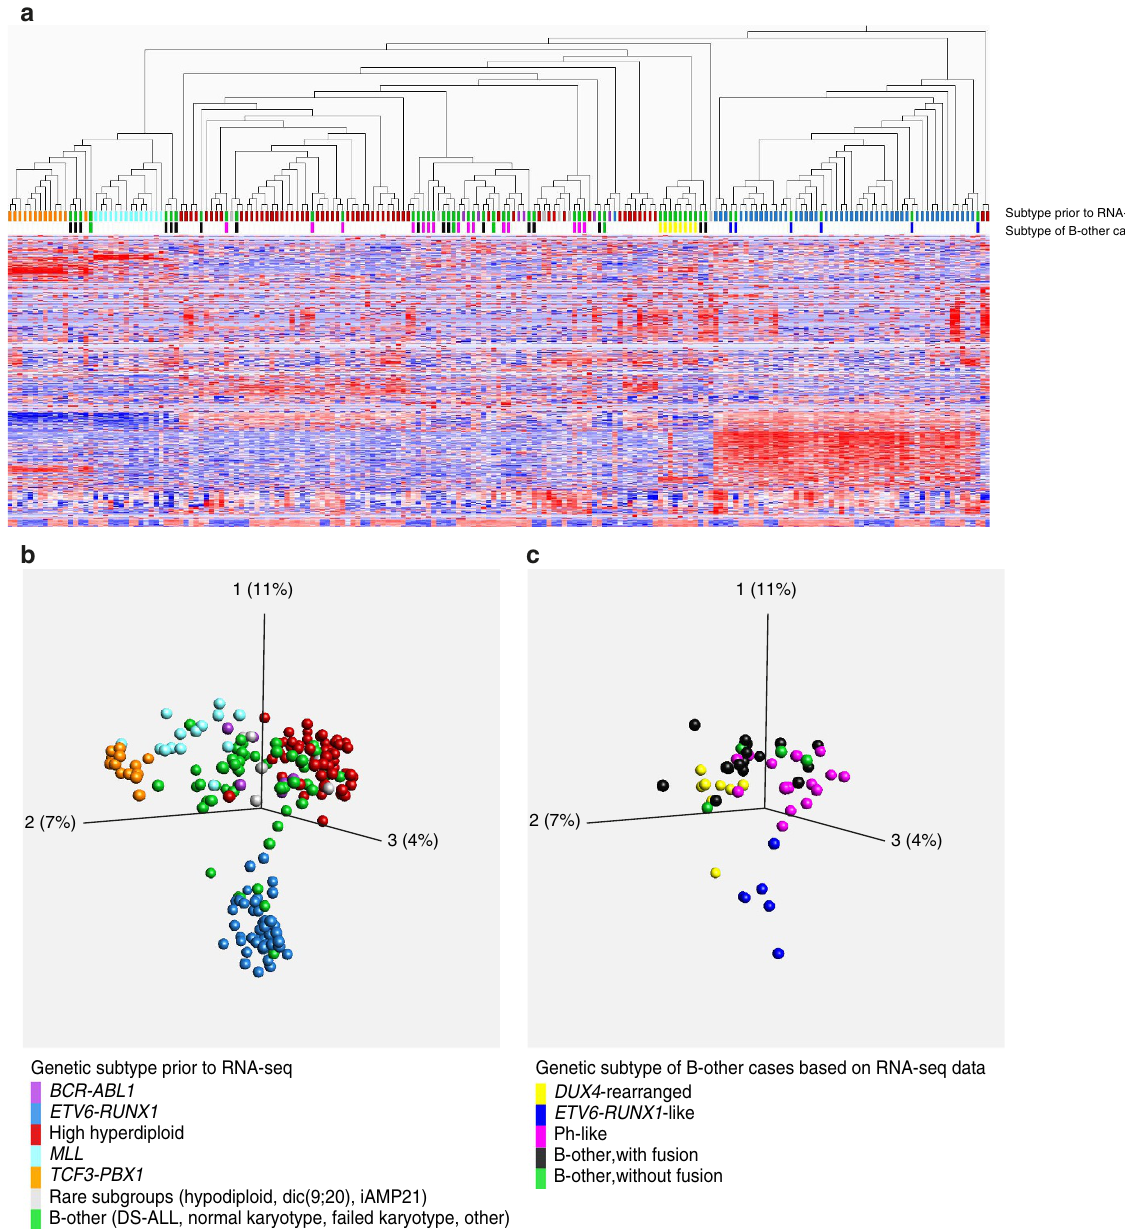
Figure 4 | Hierarchical clustering and principal component analyses of RNA-seq gene-expression data. A variance threshold was set at standard deviation 0.285, retaining 638 variables. The colour-coding of BCP ALL subtypes, used throughout the figure, is indicated in the bottom. ( a ) Unsupervised hierarchical clustering analysis of 195 BCP ALL cases. Coloured boxes below the dendogram indicate the subtype of each sample. The genetic subtype of B-other cases, based on the gene-expression and gene-fusion data, is indicated on the lower line. ( b ) Principal component analysis (PCA) of gene-expression data from all 195 BCP ALL cases. ( c ) PCA based on the data displayed in b , but only showing the 50 B-other cases colour- coded according to the genetic subtype based on the gene-expression and gene-fusion data. DS-ALL, Down’s syndrome ALL; iAMP21, intrachromosomal amplification of chromosome